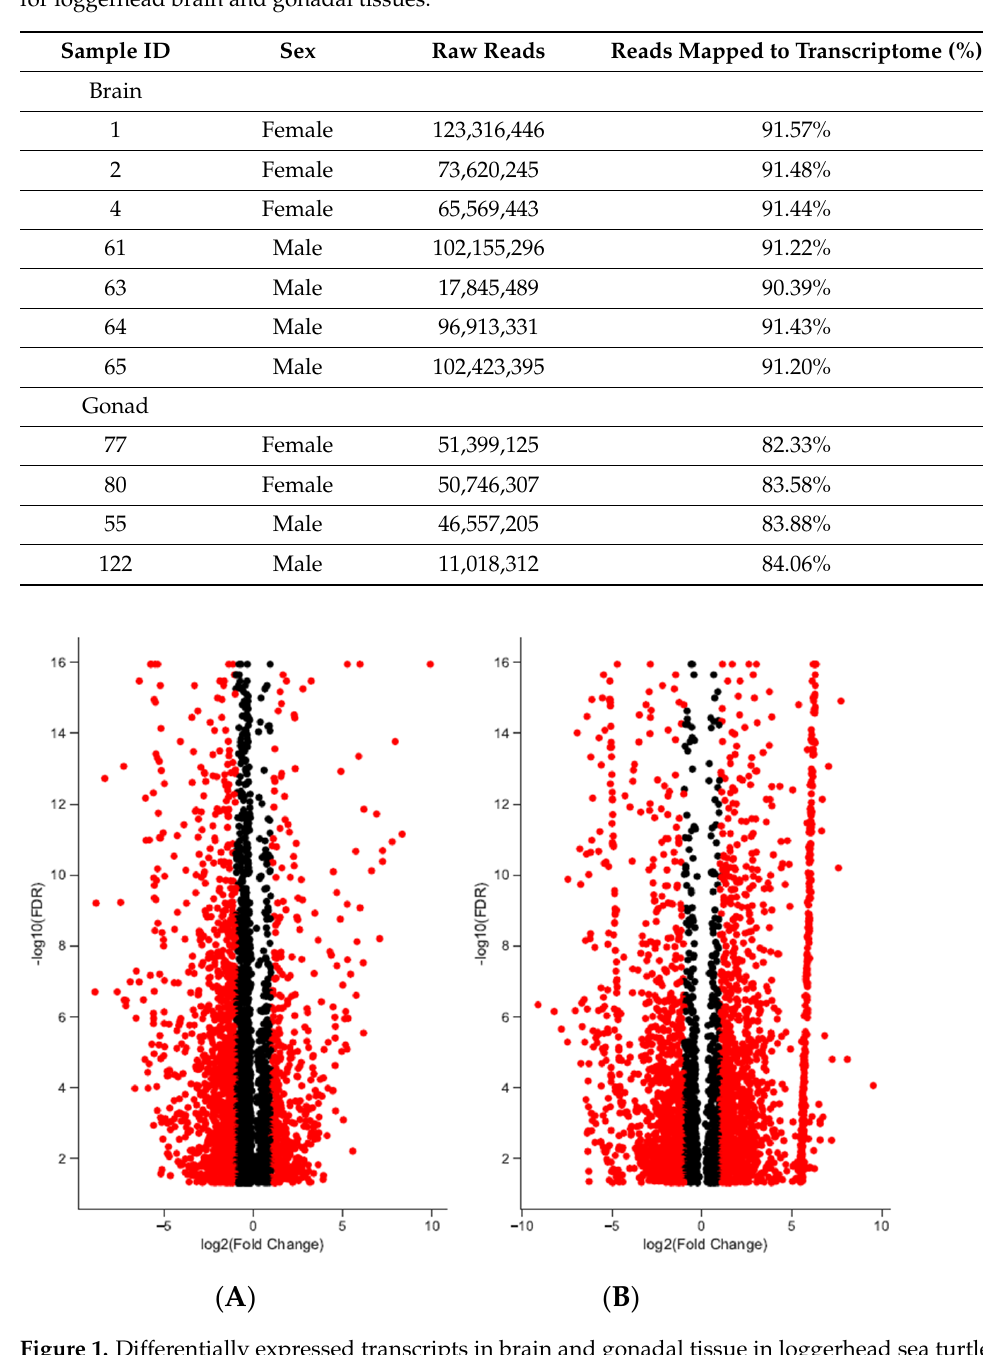
Figure 2. Heatmap of differentially expressed transcripts in loggerhead brain ( A ) and gonadal ( B ) tissue clustered by sex. Sex is indicated in sample names for females (F) and males (M). Signifi- cantly expressed transcripts (FDR < 0.001) with at least 4-fold differential expression are displayed in normalized FPKM values using the top 50 differential expression features within pairwise com- parisons. Table 1. Raw reads retrieved per sample and number of reads aligned to assembled transcriptomes for loggerhead brain and gonadal tissues. Sample ID